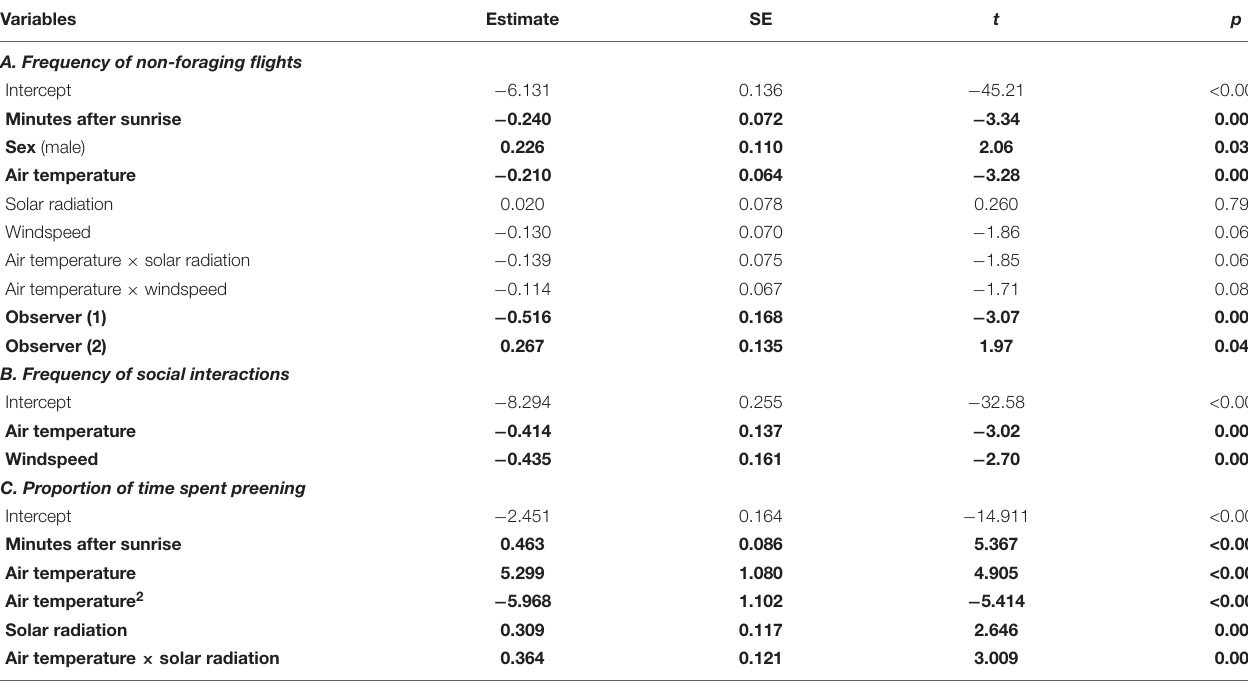
TABLE 2 | Results of REML mixed effects models testing for factors associated with non-foraging activities. Variables